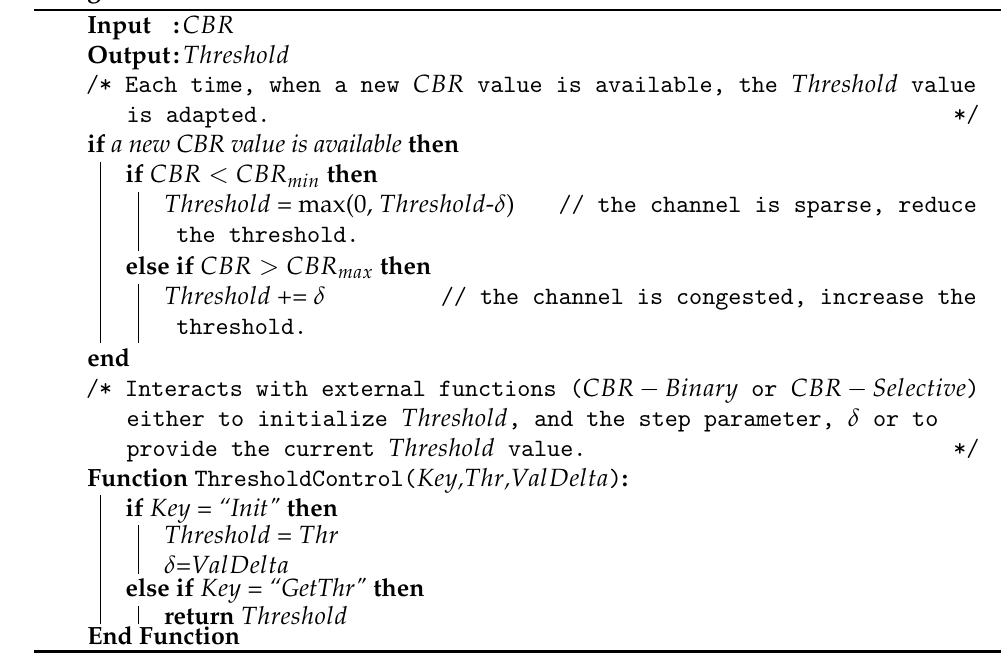
Algorithm 2: Threshold Control